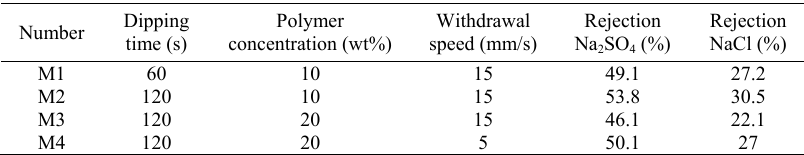
Table 2: Dip-coating parameters and rejection of membranes at 0.6 MPa operating